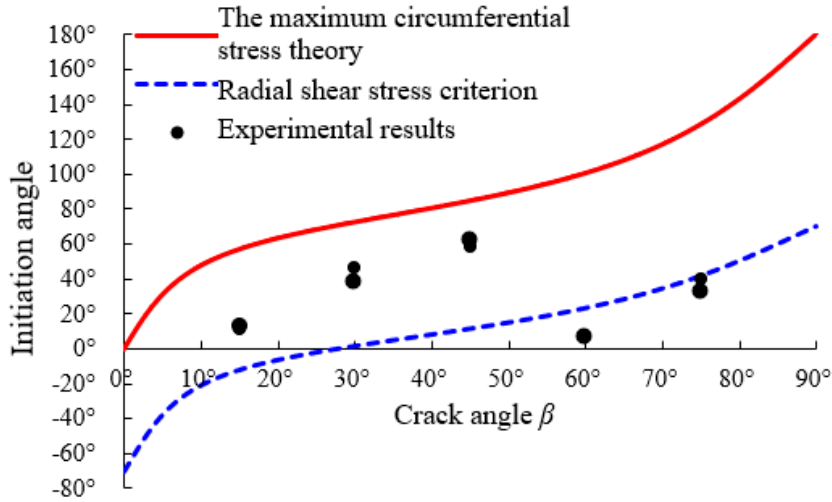
Figure 11. Comparison between theoretical and experimental initiation angles.